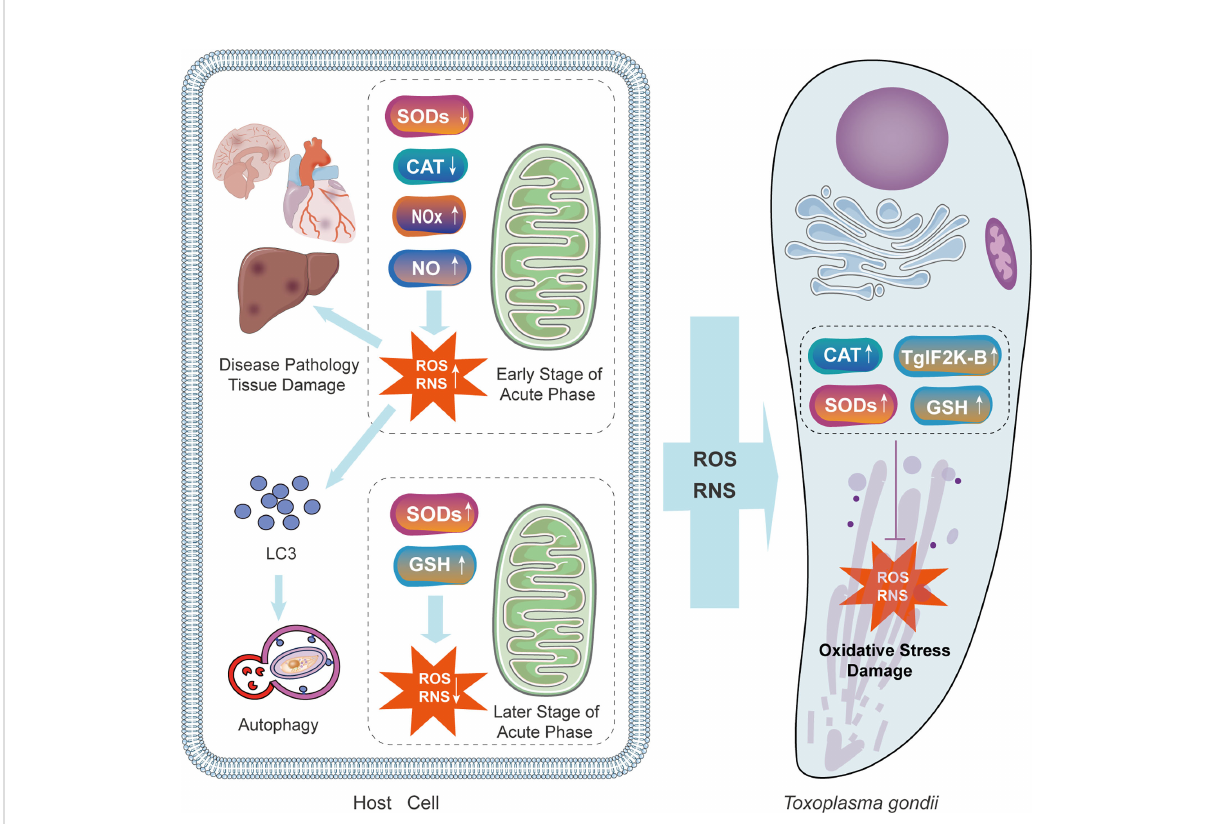
FIGURE 4 The mechanisms of oxidative injury and antioxidant defense during T. gondii infection in the parasite and the host. T. gondii infection causes immune system reaction of the host. In the early stage, the concentration of NOx and NO is raised, increasing the level of ROS and RNS. Oxidative stress caused by the host response is toxic both to parasites and the host itself. Increased ROS in host cells recruits LC3 and stimulates autophagy. In the later stage, levels of SOD and GSH are up-regulated due to the antioxidant defense of the host.